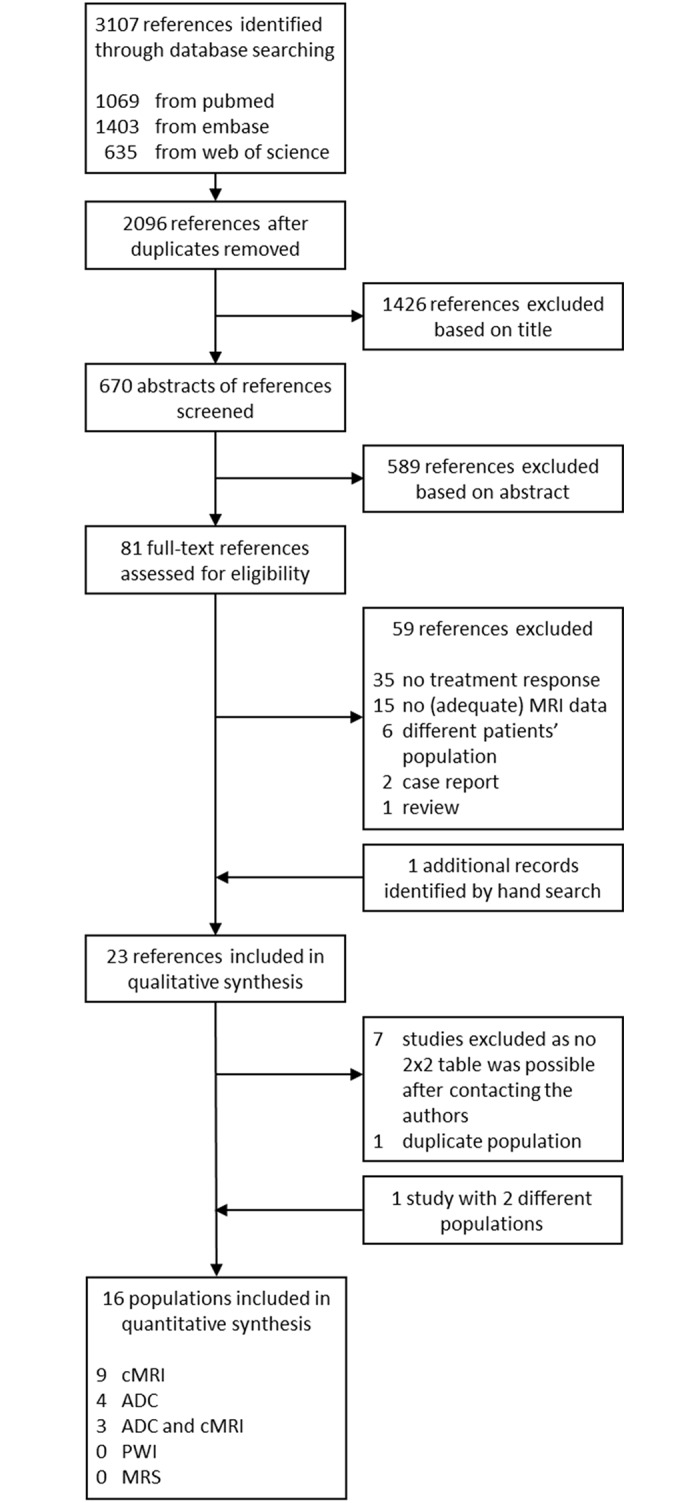
Flow chart literature searches.